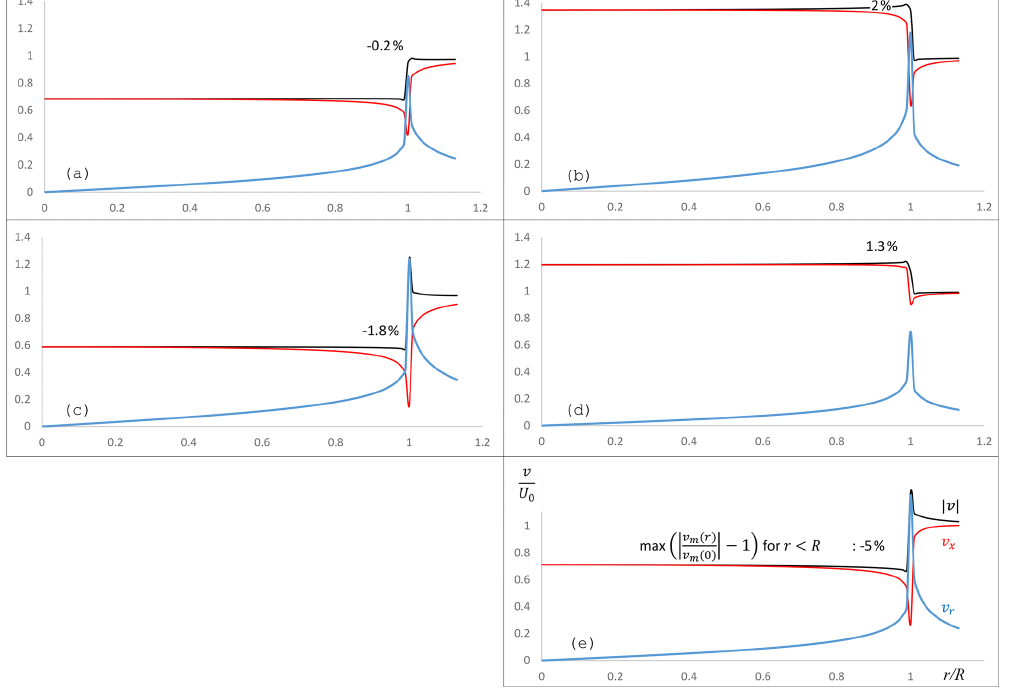
Figure 5. The velocity distribution at the disc, for flow cases (a) to (e) defined in Fig. 4. Black line: | v | m = v x /U 0 ; blue line v r /U 0 . All vertical axes have the same scale. The percentages denoting the non-uniformity of | v | m are explained in Sect.